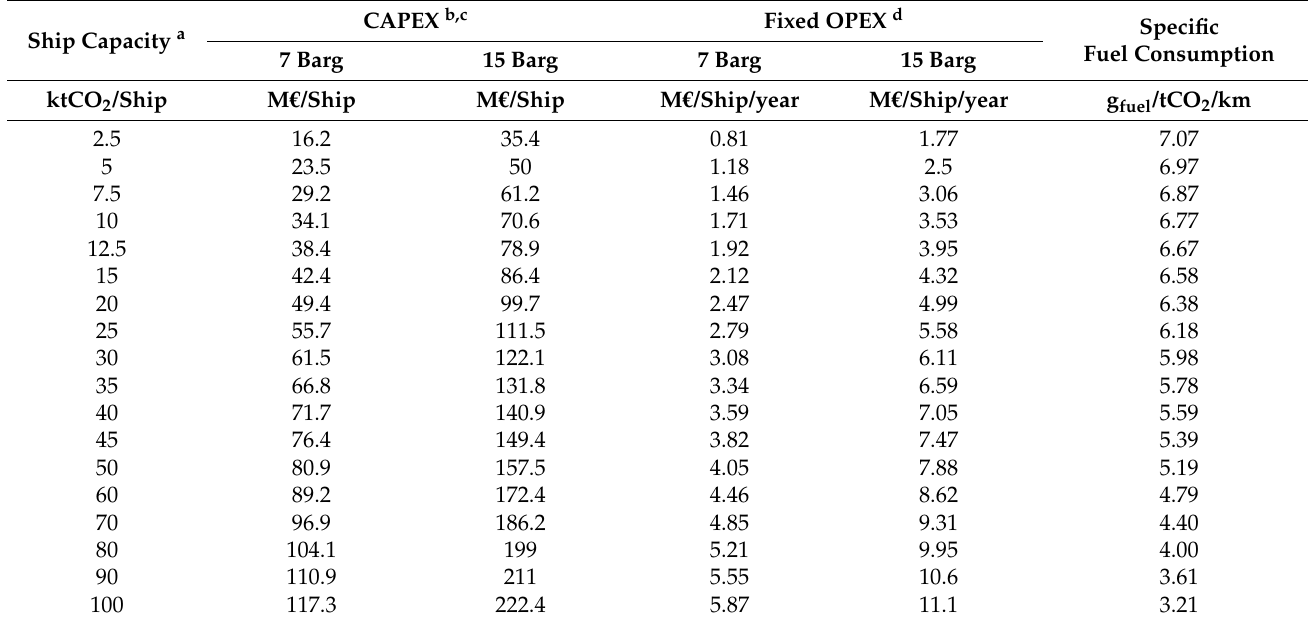
Table 4. Ship characteristics as a function of